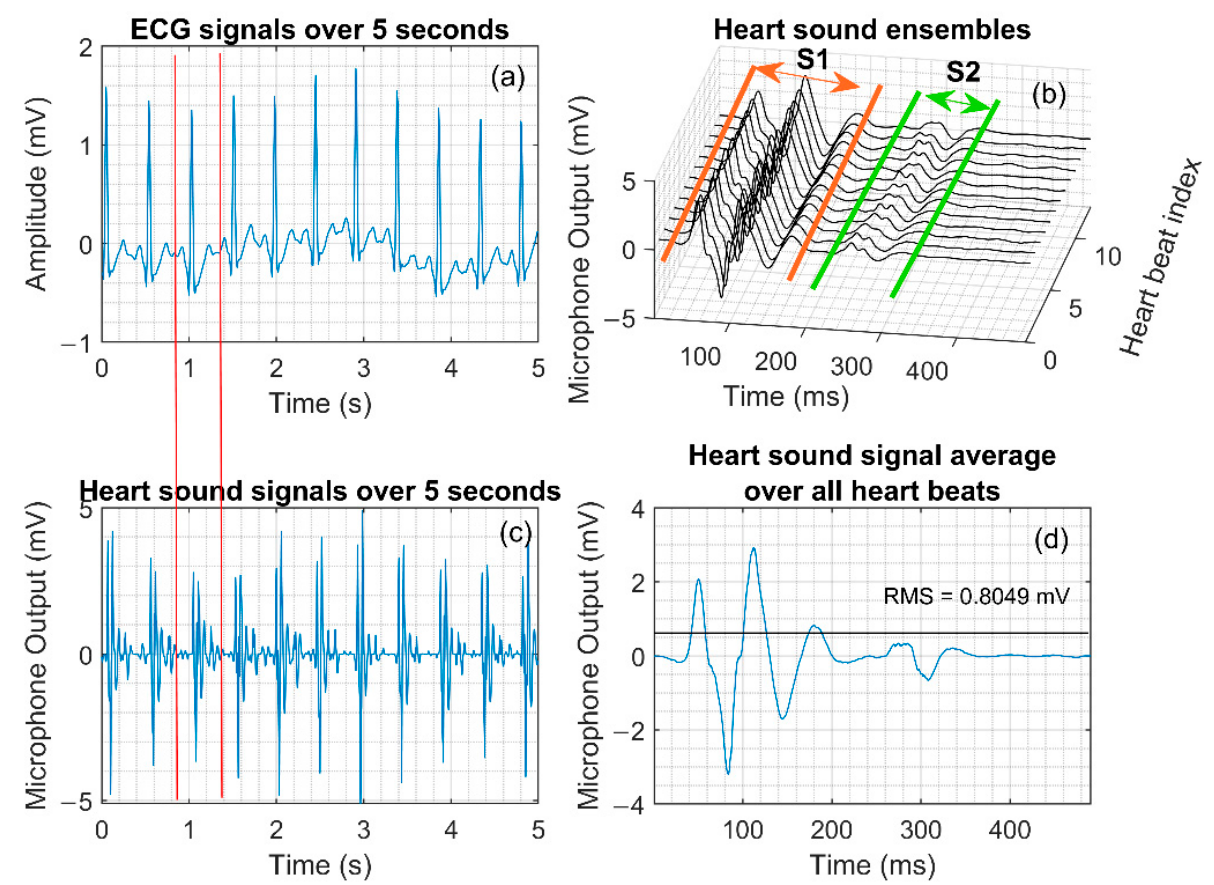
Figure 5. ( a ) ECG signal with sample beat-to-beat interval; ( b ) ensembles of heart sounds and illustration of the segmentation of S1 and S2; ( c ) heart sounds corresponding to the ECG with red vertical lines demarcating a single heartbeat; ( d ) ensemble median of waveforms in ( b ) and the RMS value of the ensemble median.